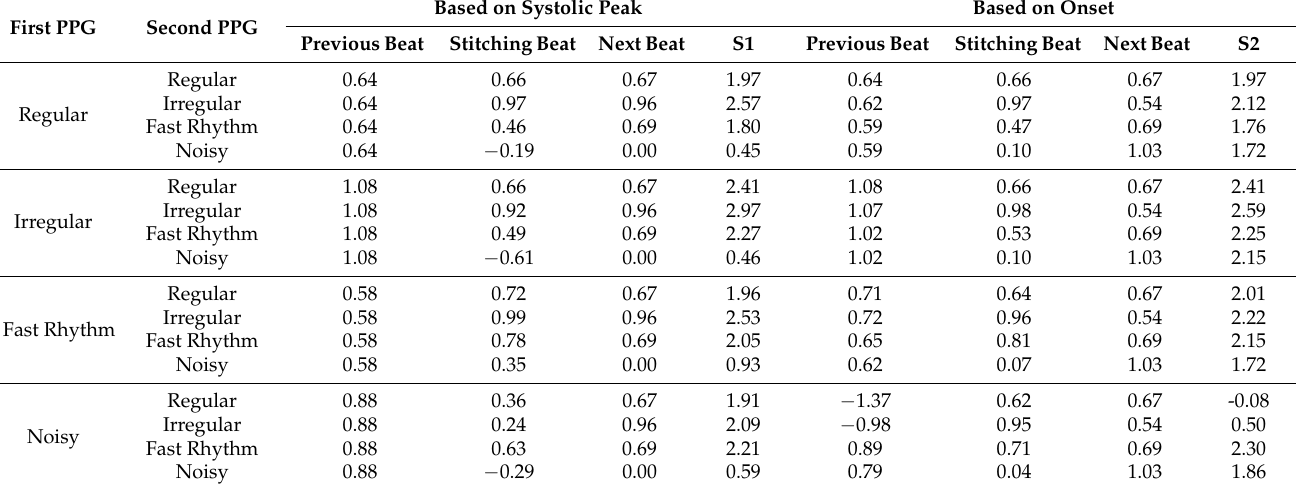
Table 1. Signal quality indices of the stitching results (“stitching beat” refers to a beat that has been stitched, “previous beat” to the beat prior to the stitching beat, and “next beat” to the beat after the stitching beat. The “signal quality index” refers to skewness of the beat).